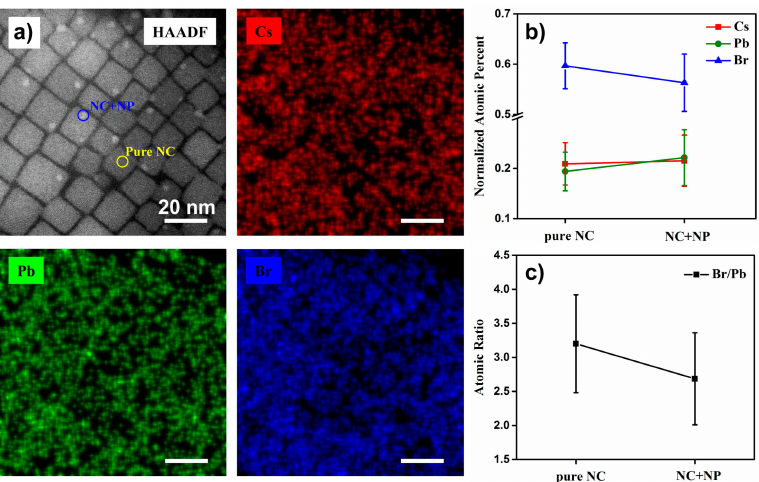
Figure 4. ( a ) STEM-EDS raw counts mappings of CsPbBr 3 NCs with the NPs. No strong variations of Cs, Pb, or Br are found in the position of the NPs. None of the auto-filter processing is applied here. ( b ) A plot of the calculated atomic percentages for Cs, Pb, and Br versus different regions (pure NC regions and NC+NP regions). We took an average of 10 quantified elemental atomic percentage results subtracted from 10 pure NC regions (i.e., indicated by a yellow circle in ( a )). The error bar is the standard deviation. Similar calculations were applied to the NC+NP regions (i.e., indicated by a blue circle in ( a )). ( c ) A plot of calculated atomic ratio of Br/Pb versus different regions (pure NC regions and NC+NP